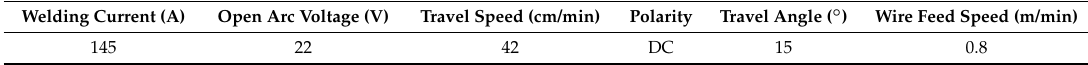
Table 4. Parameters used during the cladding process.